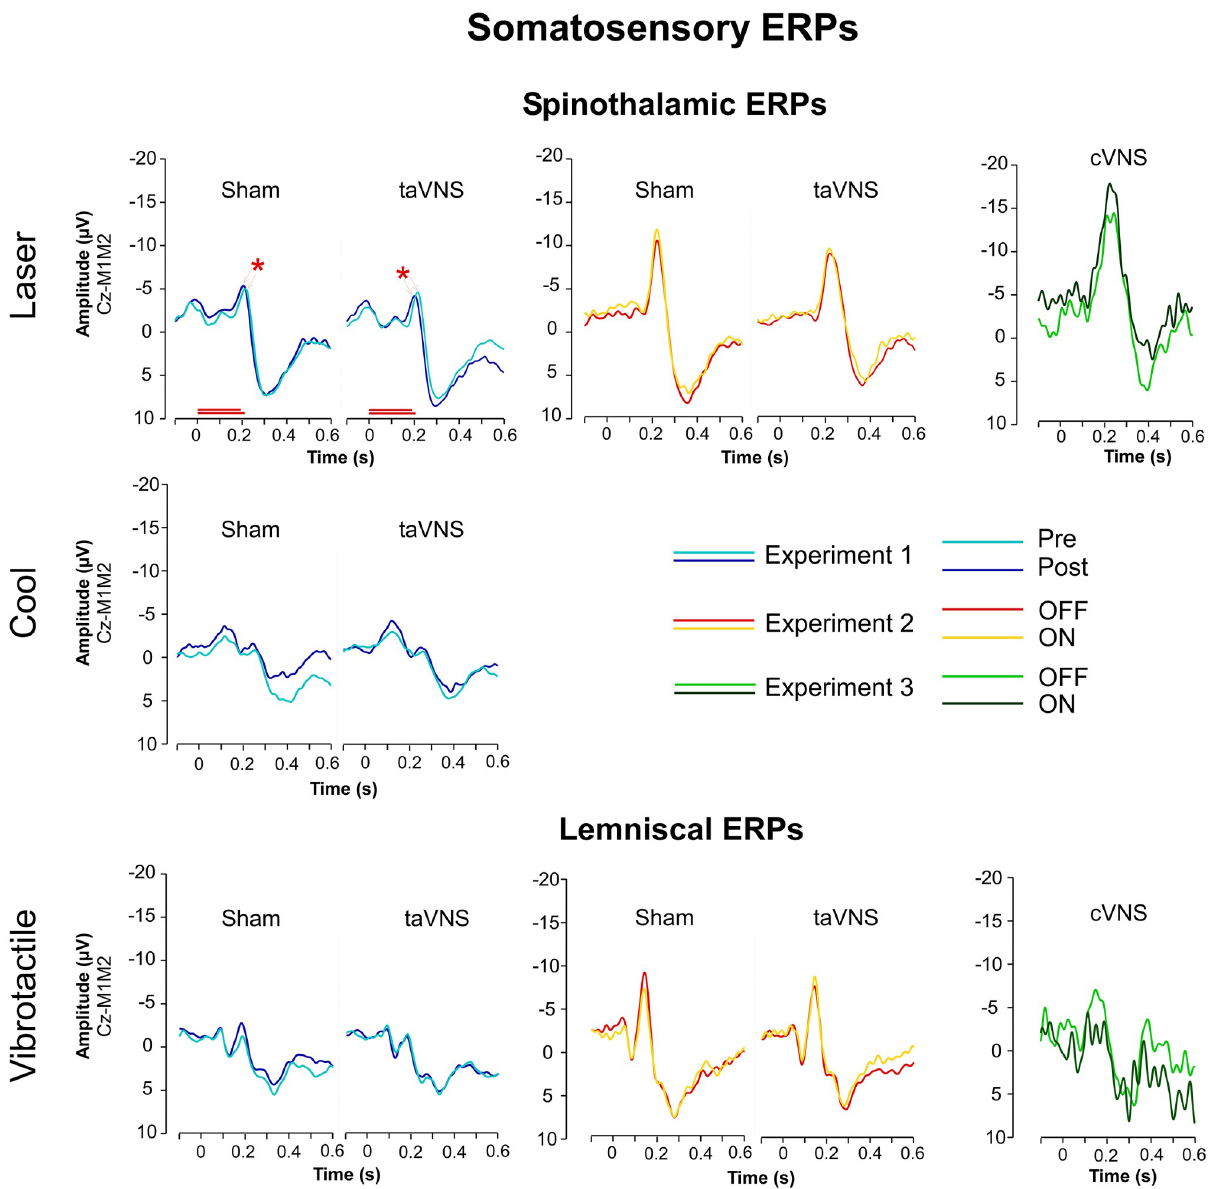
Fig 5. ERP waveforms. Each diagram represents the ERPs obtained at group level for one somatosensory modality and one experimental condition. The colors of the waveforms are specific to one experiment, one timepoint (T0 or T2) and one phase of the duty cycle (OFF or ON). The Y axes represent the amplitude of the difference in potentials ( μ V) observed at the Cz electrode, when referenced to the bilateral mastoid contacts (M1M2), with negative values at the upper end and positive values at the bottom of the axes. The X axes represent the evolution of time (in seconds) relative to the onset of the somatosensory stimulus (0s). The N2 peak was defined as the most negative deflection with a latency comprised between 0.1 to 0.5s. The P2 peak was defined as the first positive deflection after N2. The black circle and asterisk represent in Experiment 1, the statistically significant alteration observed over time in the latencies of the laser-evoked N2 peaks (p = .038). To note, the low signal to noise ratio in Experiment 1 (especially on Vibrotactile- and Cool-evoked ERPs obtained from healthy subjects) and Experiment 3 (epileptic